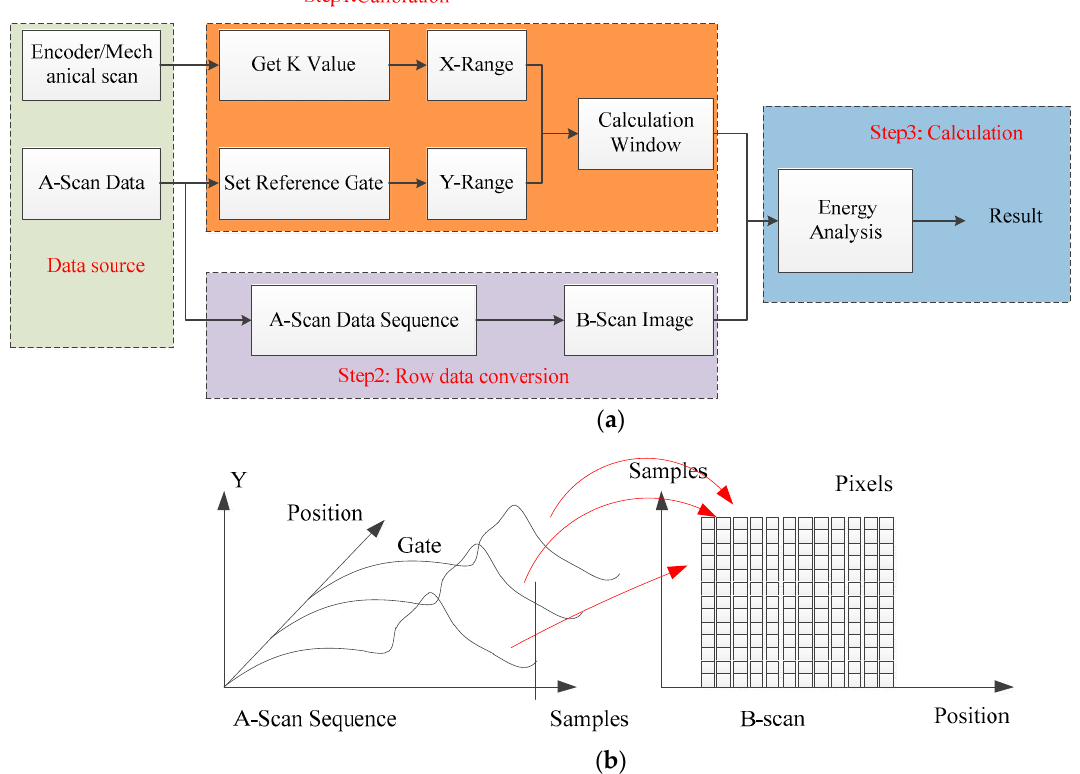
Figure 5. ( a ) The proposed processing method; ( b ) the principle of B-scan image.